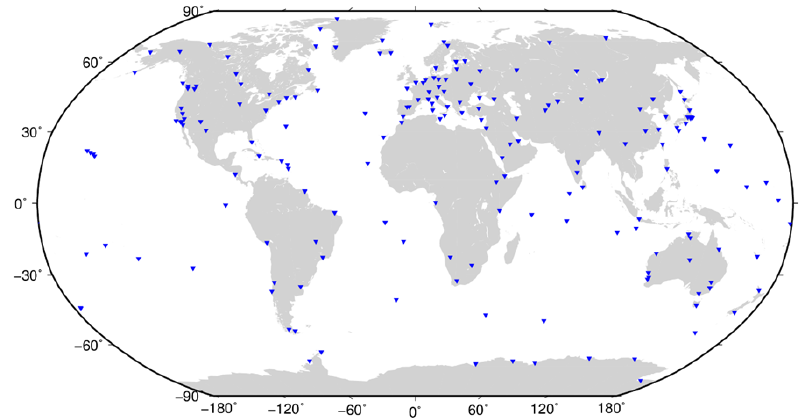
Figure 1. GNSS station network used for MG3 product computation.